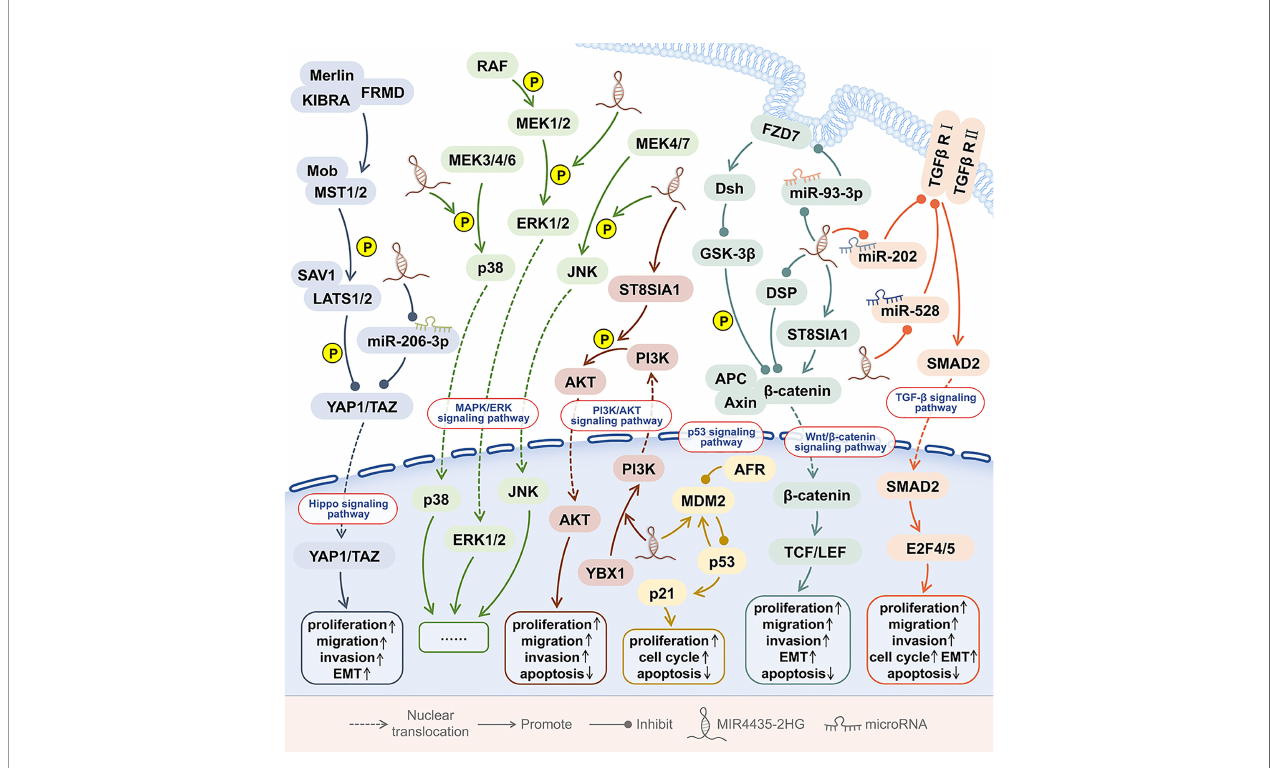
FIGURE 5 | The signaling pathways involved in MIR4435-2HG. In human tumors, MIR4435 participates in at least 6 signaling pathways, including the TGF- b signaling pathway, Wnt/ b -catenin signaling pathway, MDM2/p53 signaling pathway, PI3K/AKT signaling pathway, Hippo signaling pathway, and MAPK/ERK signaling